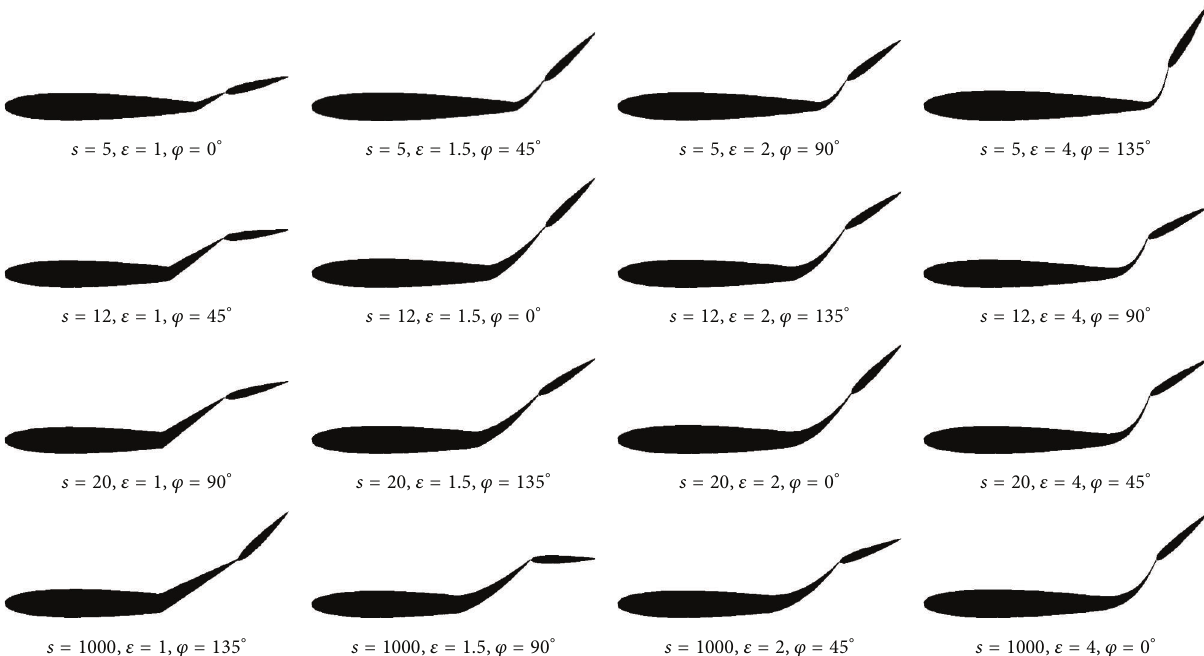
Figure 6: Fish-like deformation under various 𝑠 , 𝜀 , and 𝜑